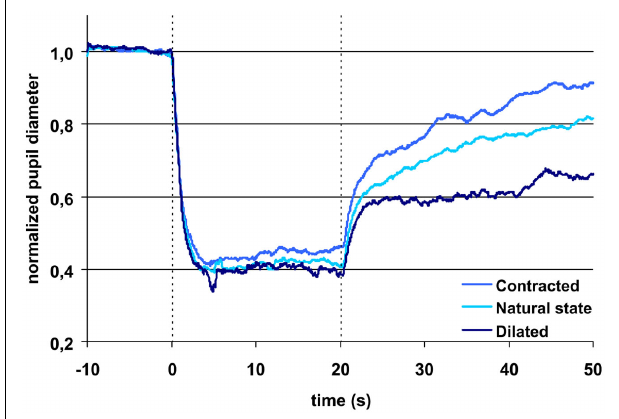
FIGURE 2 | Pupillary contraction to a blue light stimulus (470nm) as a function of time (s). Time period, stimulus luminance, and size of input pupil as in Figure 1 .The uppermost blue graph represents pupillary contraction, when the input pupil was miotic and the dark blue when it was mydriatic.The light blue graph between the two represents pupillary contraction with the input pupil in the natural state.The vertical dashed lines denotes light on and off (cf. Figure 1 ). In comparison with the graphs in Figure 1 , contraction is larger during light on in all graphs. Post light stimulus redilatation is far slower and dependant on the area of the input pupilla and hence the retinal photon load, in marked contrast to the graphs in Figure 1 . Each graph represents mean values from 10 subjects. For details, see Table 1